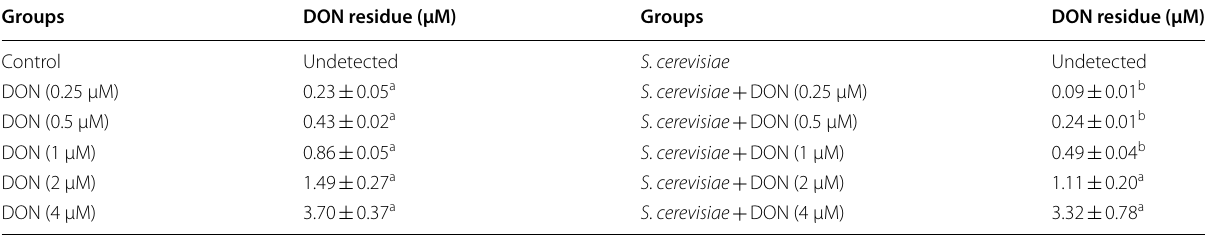
The different lowercase letters in the same rows indicated the significant differences ( p < 0.05), while the same lowercase letters in the same rows indicated the insignificant differences ( p > 0.05)